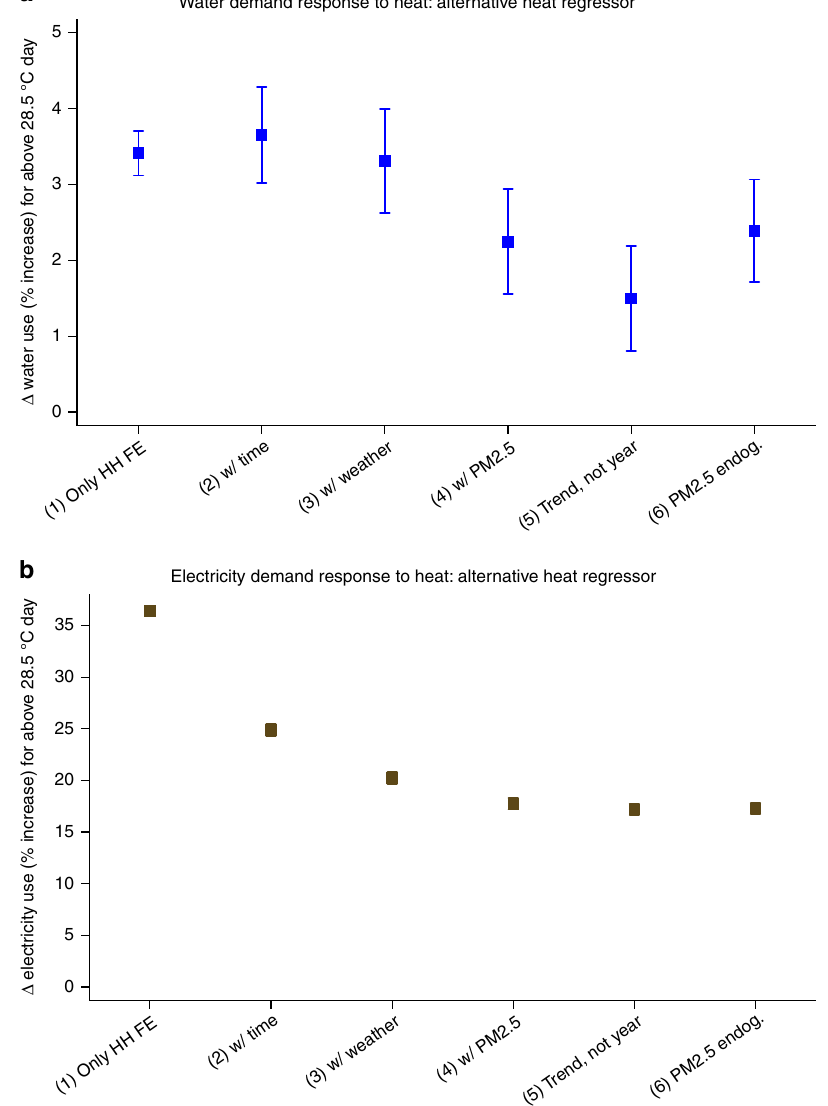
Fig. 4 Alternative heat covariate in the household demand model. 95% Con fi dence intervals for the percent increase in a water use and b electricity use, from a 0 to 100% variation in the proportion of days with daily mean temperature above 28.5 °C — an alternative key regressor. All speci fi cations include a full set of household fi xed effects. Relative to speci fi cation 1, speci fi cation 2 includes time controls. Relative to 2, speci fi cation 3 includes weather controls. Relative to 3, speci fi cation 4 controls for average daily mean PM 2.5 . Relative to 4, speci fi cation 5 replaces year fi xed effects with a linear time trend. Relative to 4, speci fi cation 6 instruments for PM 2.5 with Southeast Asia fi re activity variables and Singapore thermal gradients and wind